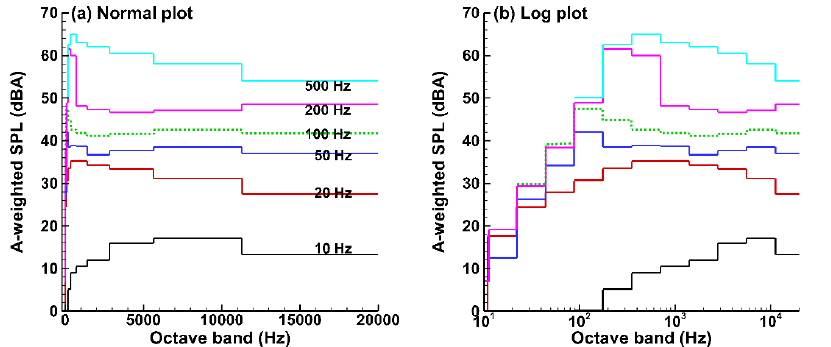
Figure 13. A-weighted sound power level (unit: dBA) of the sound signals generated at different glottal vibration frequencies at ( a ) normal scale and ( b ) logarithmical scale.